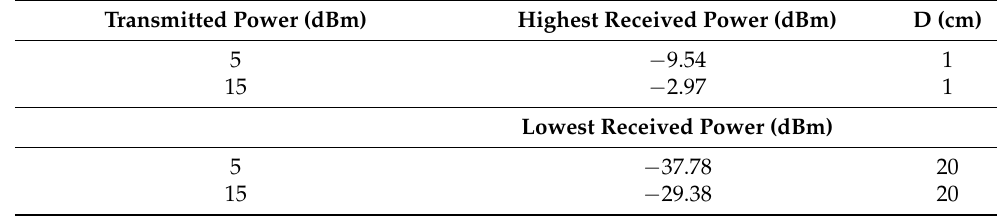
Table 2. Summary of the Received Power of the Proposed WPT System.